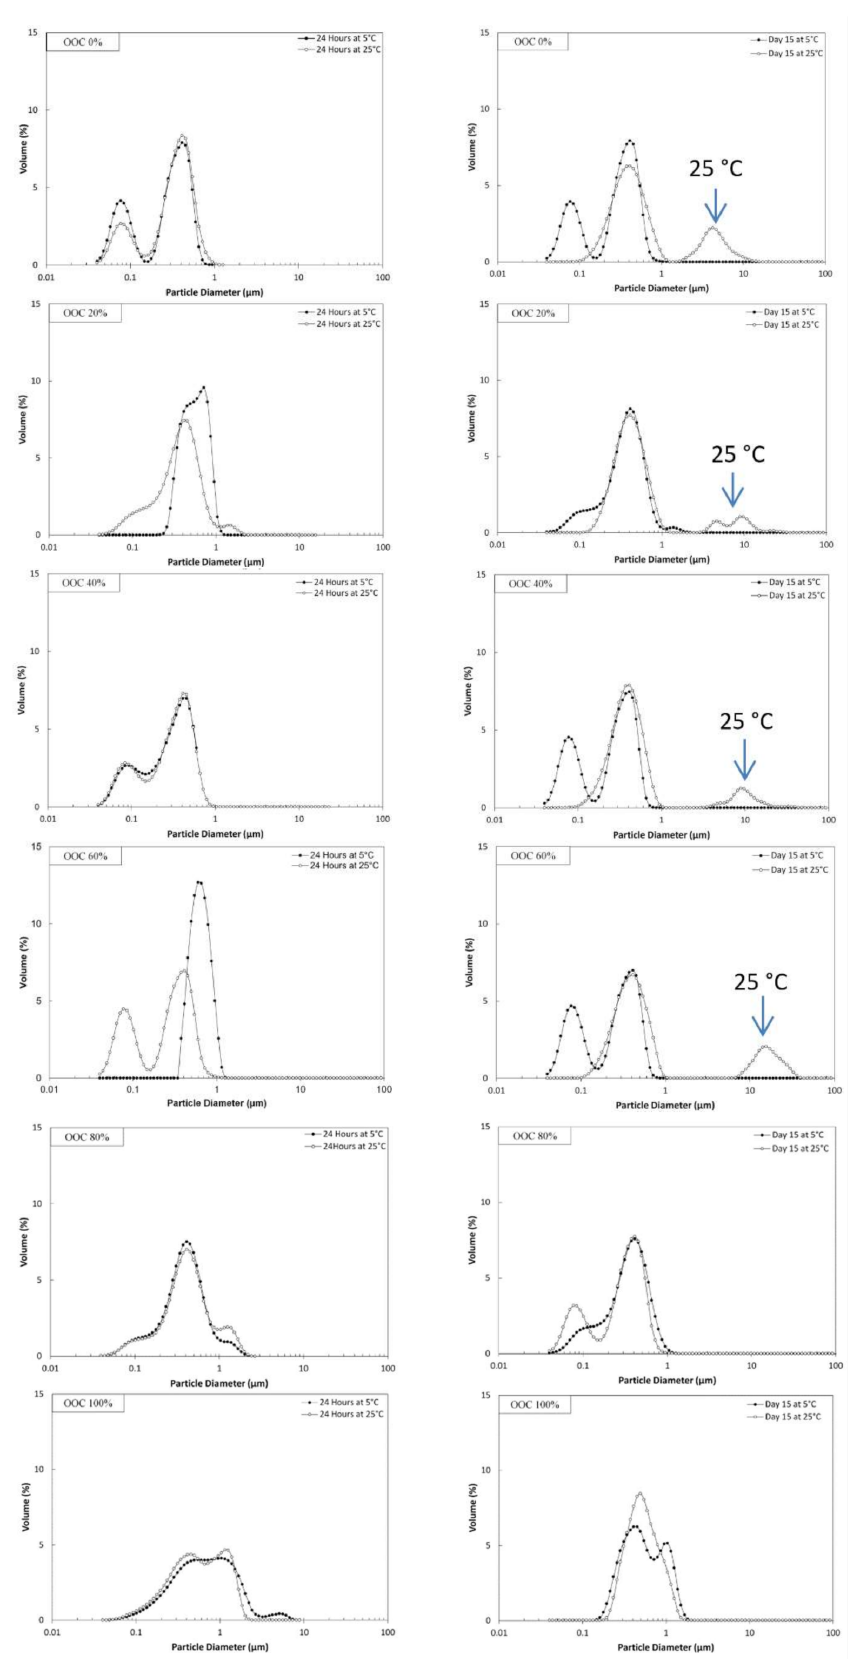
Figure 4. Droplet size distributions of emulsions prepared using 1% ( w/w ) OOC extracts and